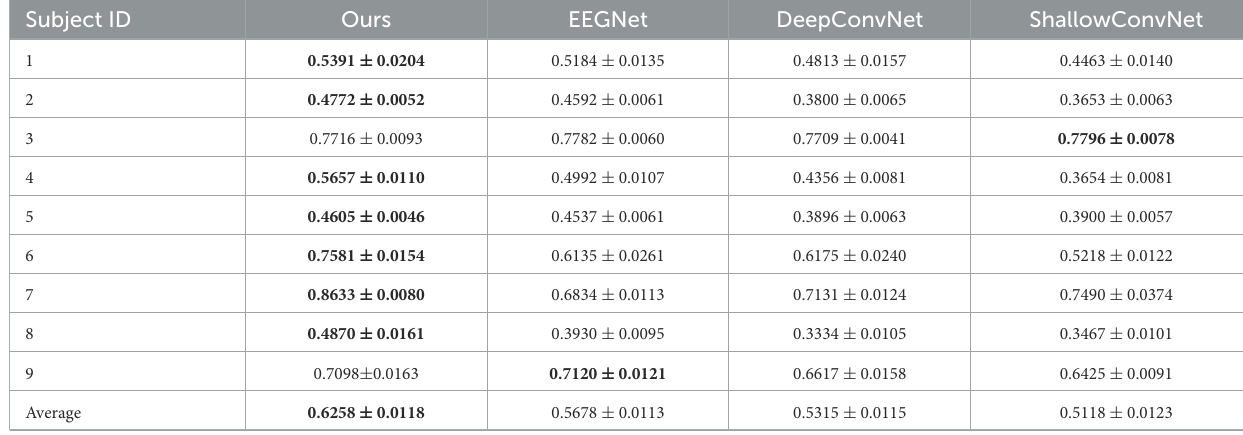
TABLE 2 Decoding performance on fingerflex dataset of each subject, the best results in each domain are bolded.